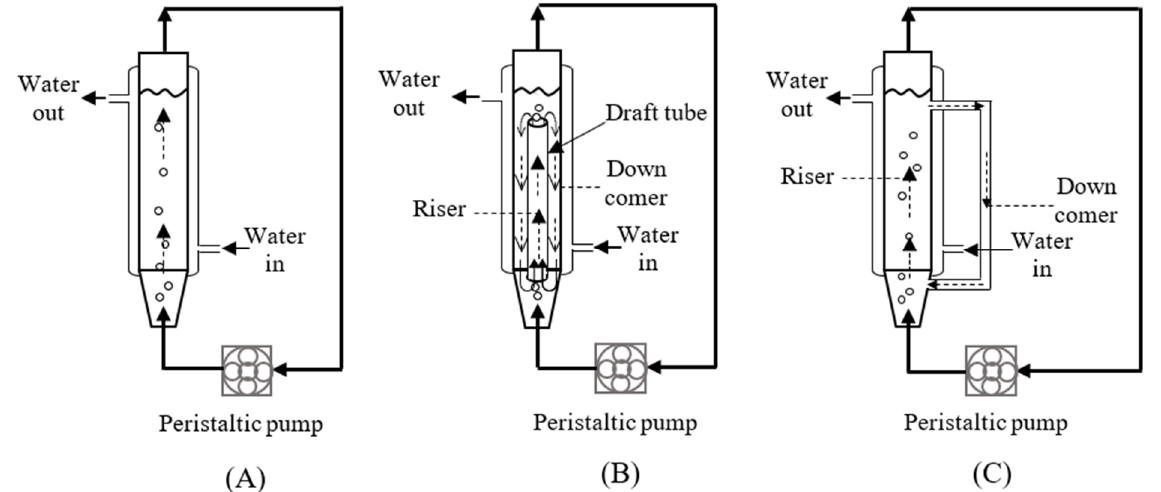
Figure 1. Configuration of bubble column and gas-lift column bioreactors for butanol fermentation. ( A ): bubble column; ( B ): gas-lift column bioreactor with internal loop and draft tube and ( C ): gas-lift column bioreactor with external or outer loop.